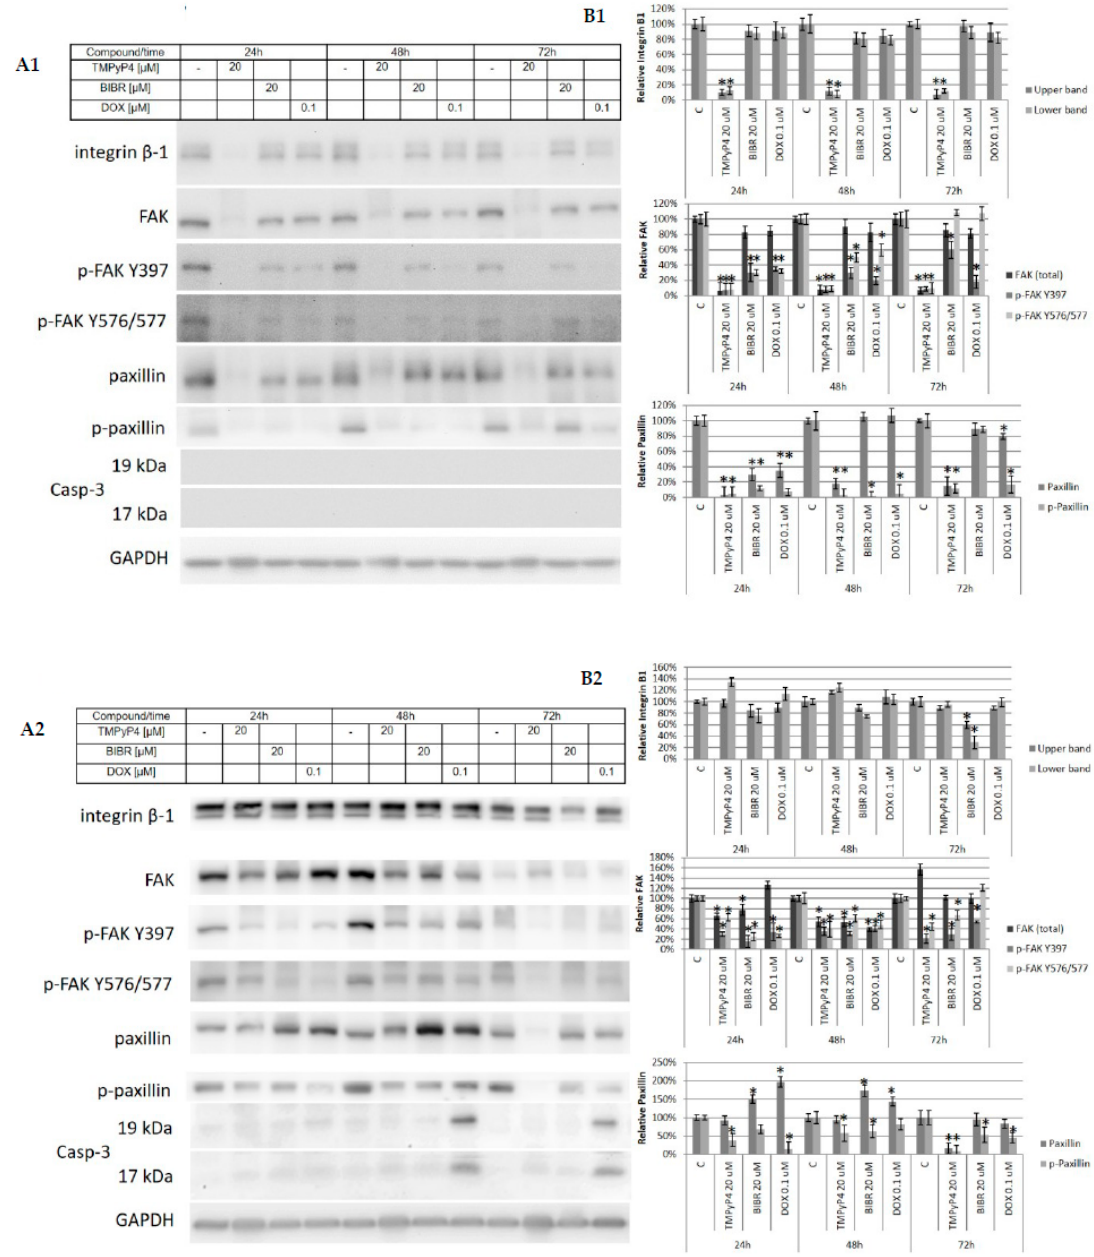
Figure 9. TMPyP4 down-regulates proteins engaged in adhesion pathway without inducing apoptosis. MCF7 and MDA-MB-231 cells were subjected to treatment with TMPyP4 (20 µ M), BIBR 1532 (20 µ M) or DOX (0.1 µ M) in a time-course experiment (24, 48, or 72 h). After individual time intervals, cells were lysed, and immunoidentification of B1 integrin, FAK (including p-FAK Y397 and p-FAK Y576 / 577) and paxillin (including p-paxillin) were performed ( A ). GAPDH was used as a loading control. Additionally, caspase-3 detection was performed, but due to a mutated caspase-3 coding gene in MCF7 cells, immunodetection did not reveal any signal. Densitometry analysis ( B ) was performed out of 3 scanned membranes from 3 independent experiments relative to the loading control, GAPDH. * p < 0.05, relative to control sample.